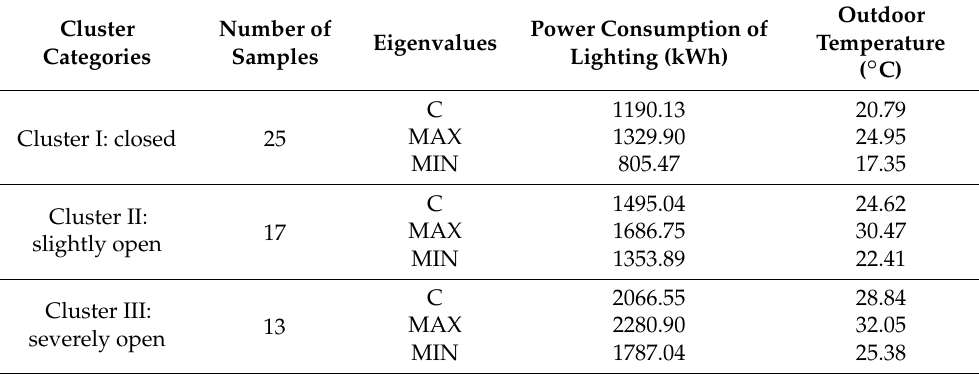
Figure 18. Recognition results of air-conditioning usage conditions with different variable durations. Table 9. The detailed information of the samples for a whole year by KNN method.